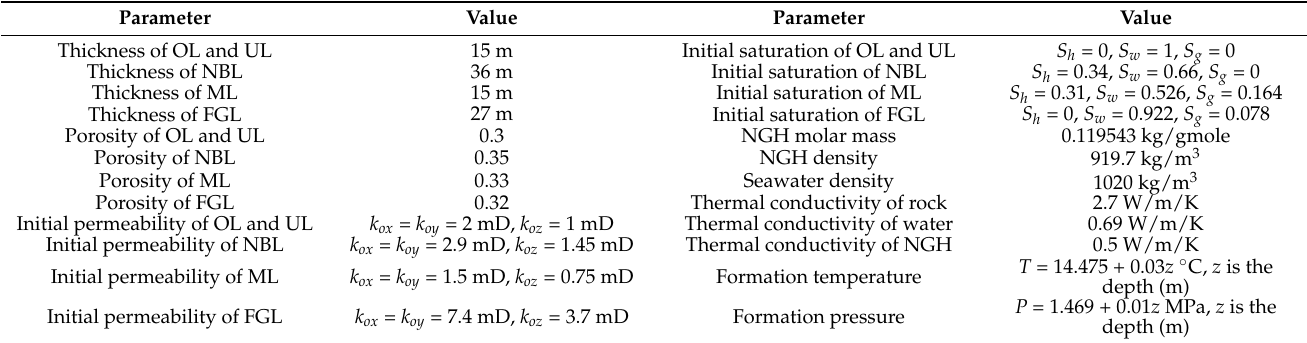
Table 1. Numerical simulation model parameters for station W17 in Shenhu sea.